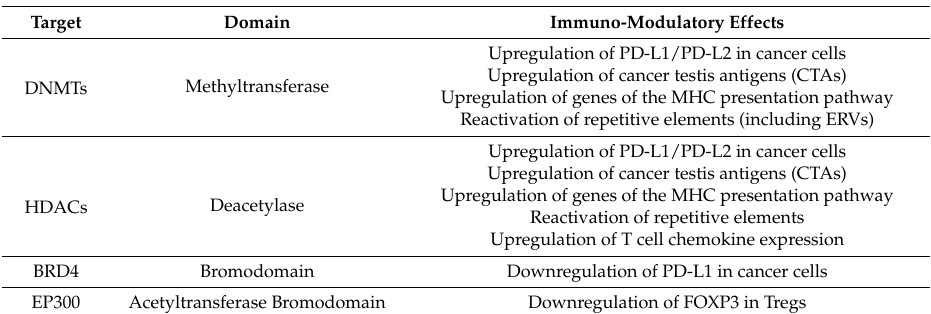
Table 1. Described effects of inhibitors of the indicated epigenetic targets and targeted domains in immuno-oncology-related